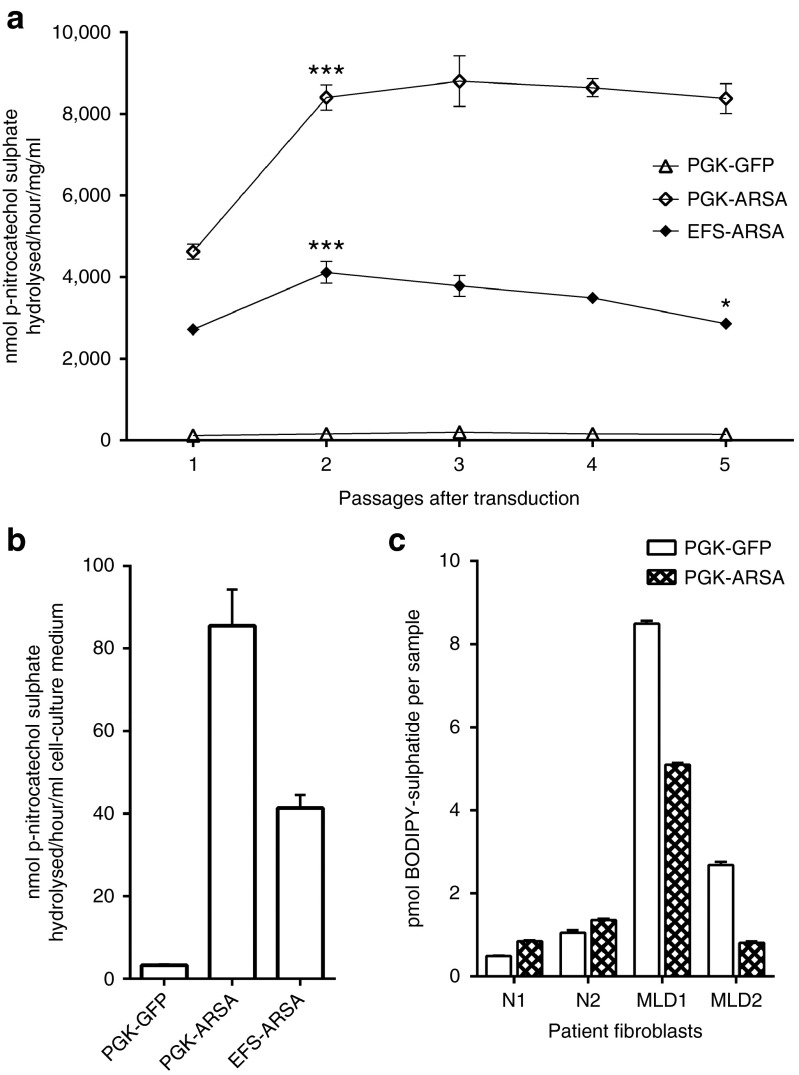
Foamy virus vector (FVV) mediates high and sustained expression of ARSA in mMSCs. (a) Lysates of m-MSC transduced cells were taken at each passage from 1 to 5 post-transduction. Lysates were mixed with σ-nitrocatechol sulphate in conditions that specifically enable hydrolysis to be catalyzed by ARSA. The nmol of substrate hydrolyzed per hour and per mg of total protein per ml are given as mean + SD of data from biological triplicates. Two-way analysis of variance with Bonferroni multiple comparisons tests was used to identify significant differences between passages of the same transduced mMSCs. Where a passage was identified to be significantly different from the previous passage of the same population, asterisks are shown to indicate the P value. (b) The cell-culture medium of mMSCs transduced with the FVV indicated was collected and used in the ARSA assay. The nmol of substrate hydrolyzed per hour per ml of cell-culture medium is given as mean + SD of data from biological triplicates. (c) Human fibroblasts from two normal donors (N1 and N2) and two metachromatic leukodystrophy patients' fibroblasts were loaded with BODIPY-sulphatide then cultured in the presence of dilute cell-culture medium from FVV:PGK-GFP (white) or FVV:PGK-ARSA (diamond patterned) transduced mMSCs. After 24 hours, the pmol of BODIPY-sulphatide present in the samples was determined by HPLC analysis. Values (mean + SD of technical triplicates) are normalized to BODIPY-lactosylceramide which was added immediately prior to lipid extraction as a recovery standard.